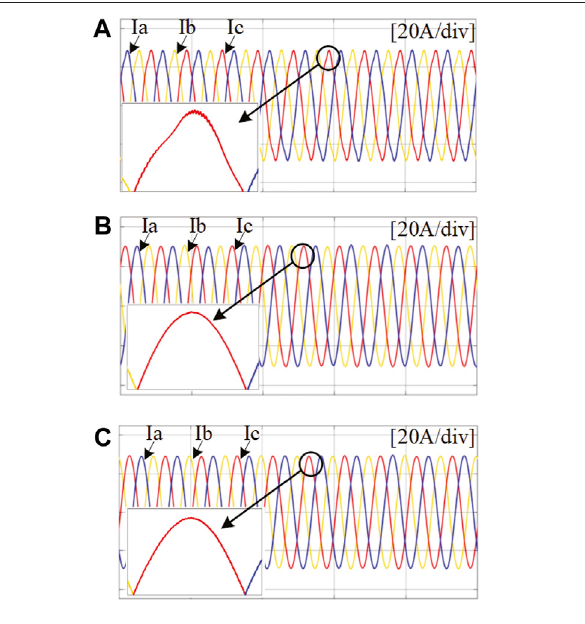
FIGURE 21 | Grid-connected current waveform; (A) without compensation; (B) with DVC compensation; (C) with PLL